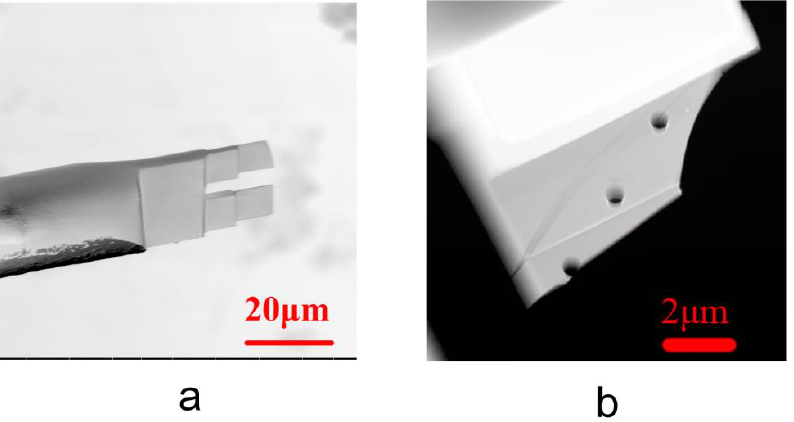
Figure 1. Photographs of microtubule sections and submicron pores on the sections. ( a ) Scanning electron micrographs of TEM sections made along the axial direction of the microtubules using an ion beam. ( b ) Submicron processed using an ion beam perpendicular to the TEM section of the TEM image.